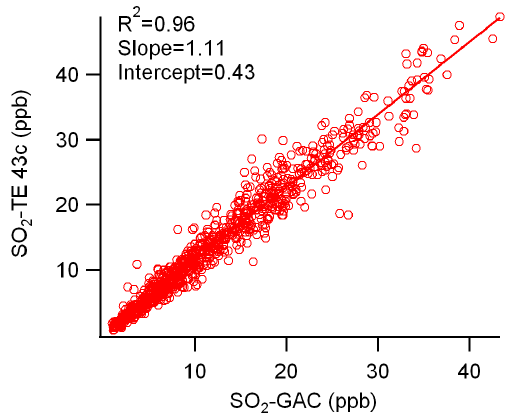
Fig. 10. Correlations of SO 2 measurement by the GAC-IC system and the TE 43c analyzer.